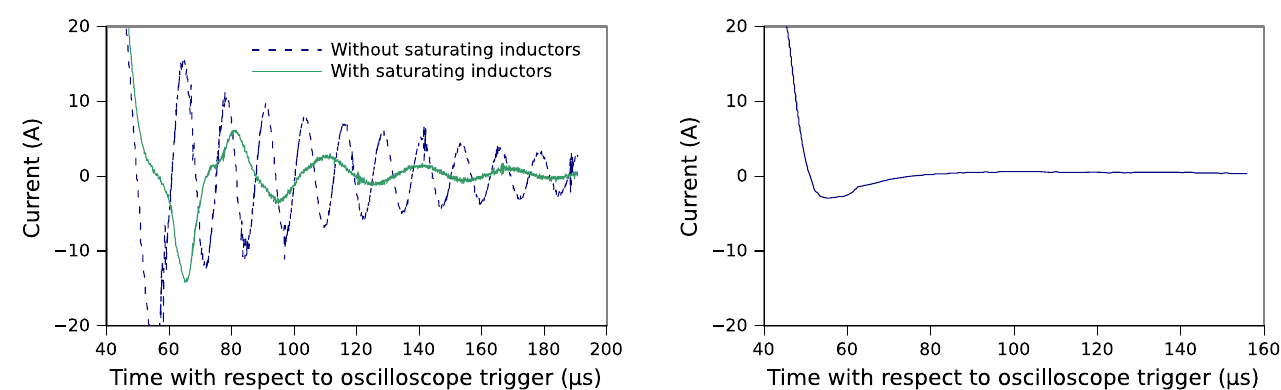
FIG. 10. Measured postpulse current following 250 A flat-top magnet current: without saturating inductors (blue dashed trace) and with saturating inductors (green solid trace).